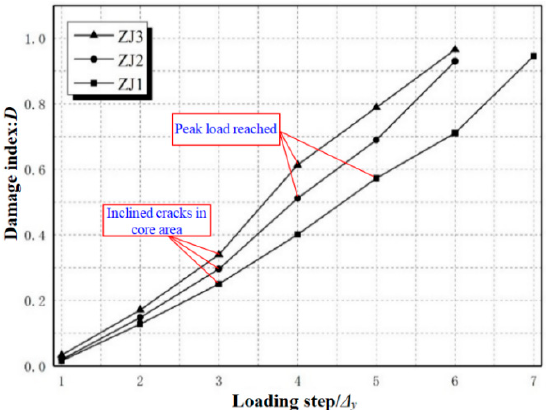
Figure 7. Damage evolution curves of the precast specimens.